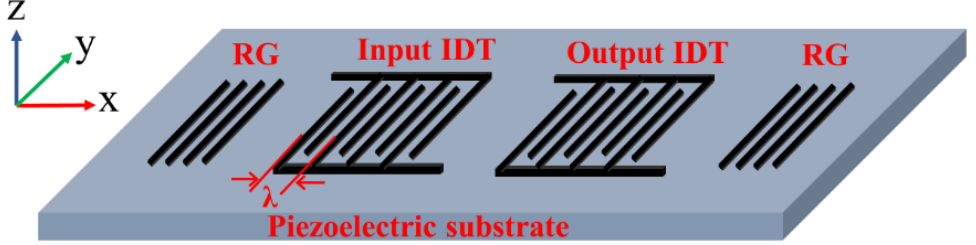
Figure 1. The schematic diagram of a dual-port SAW resonator.